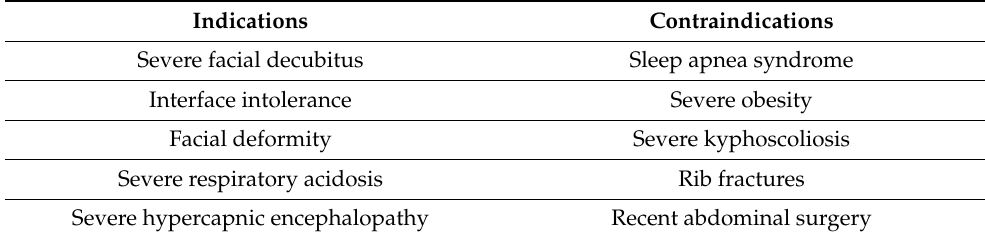
Table 1. NPV indications and